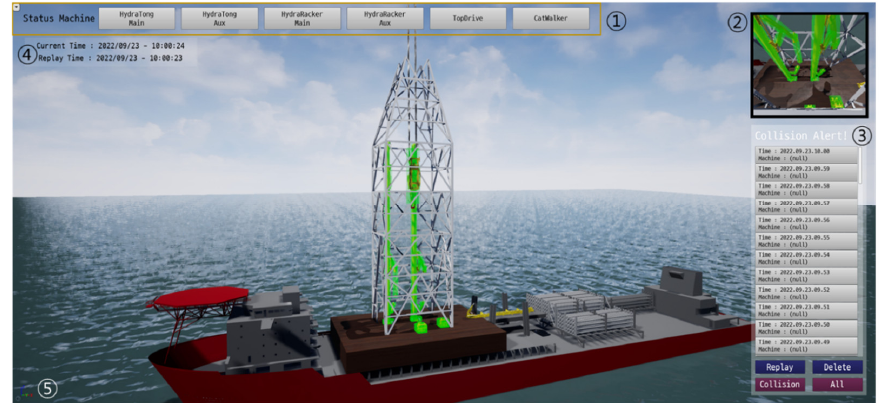
Figure 8. Outlook of display system developed. ① Machine status bar; ② Time bar; ③ CCTV box; ④ Play mode bar; ⑤ Replay selection.